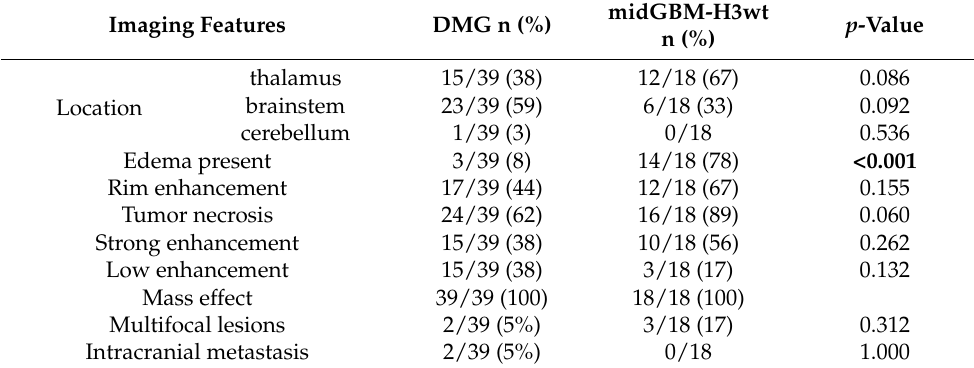
Table 4. MRI findings and their distribution in DMG and midGBM-H3wt cohorts, including correla- tion analysis